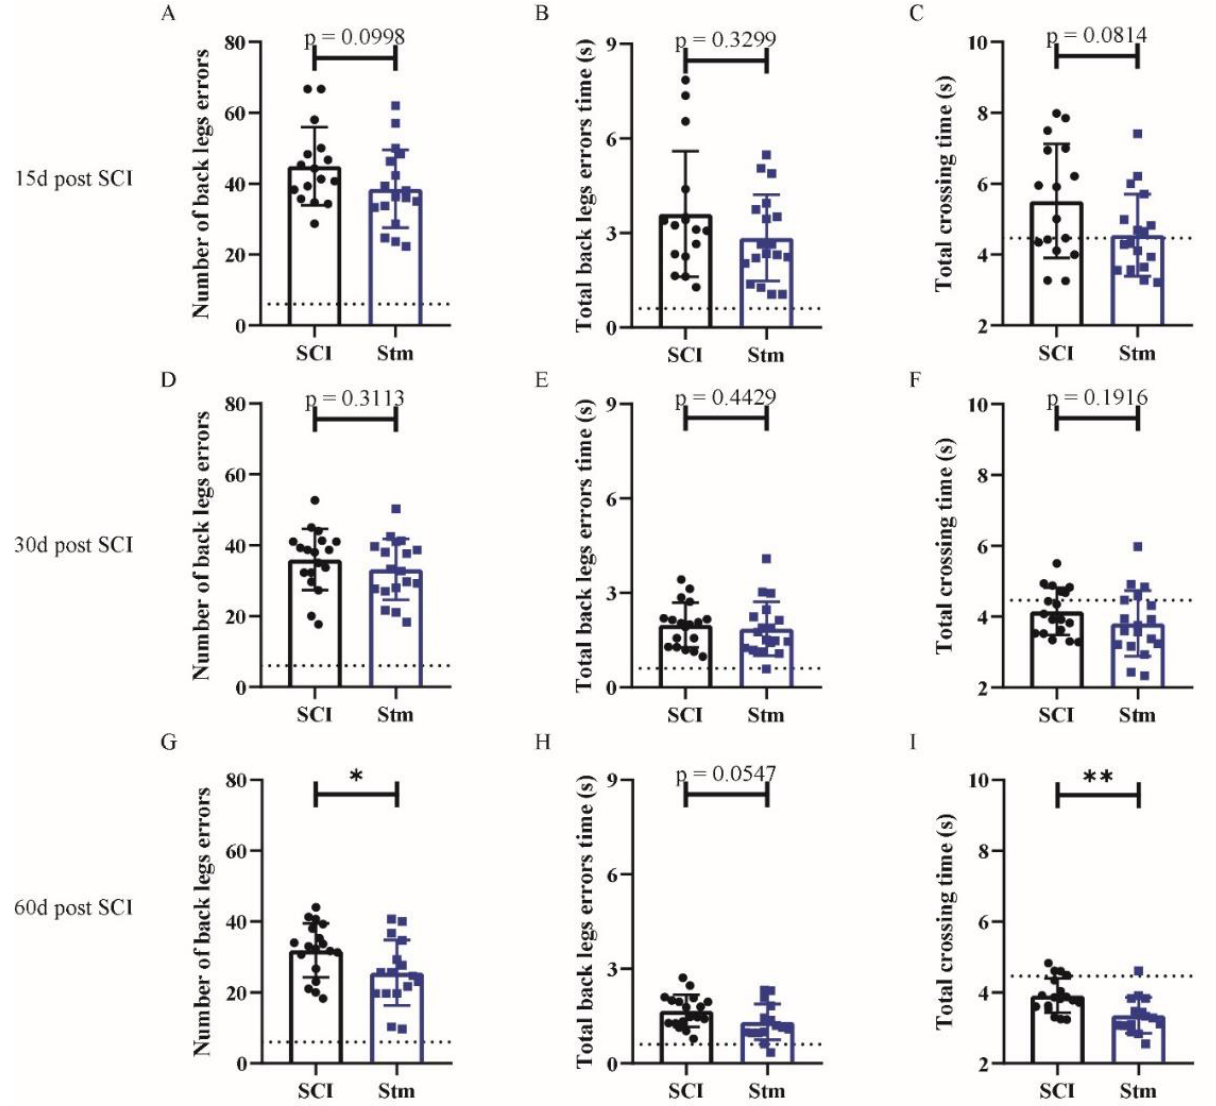
Figure 6. rTSMS treatment induces locomotor recovery after contusive SCI in rats. Quantification of locotronic evaluation at ( A – C ) 15 days, ( D – F ) 30 days and ( G – I ) 60 days after SCI. Parameters are ( A , D , G ) number of back-leg errors, ( B , E , H ) total back-leg errors’ time and ( C , F , I ) total crossing time. Quantifications are expressed as average ± SD; n = 16 animals per SCI group and n = 18 animals per Stm group at 15 days, n = 18 animals per SCI group and n = 18 animals per Stm group at 30 days and n = 18 animals per SCI group and n = 16 animals per Stm group 60 days after SCI. Dashed lines correspond to the baseline parameters obtained during locotronic habituation (7 days before SCI). Quantifications are expressed as average ± SD. Statistical evaluations are based on the Mann–Whitney test (* = p < 0.05 and ** = p <